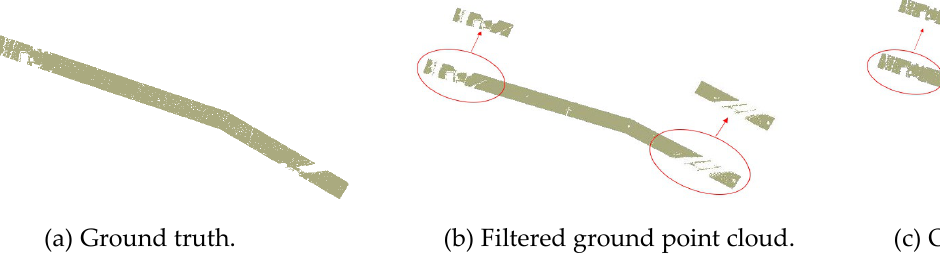
Figure 7. Extraction result of the ground point cloud.